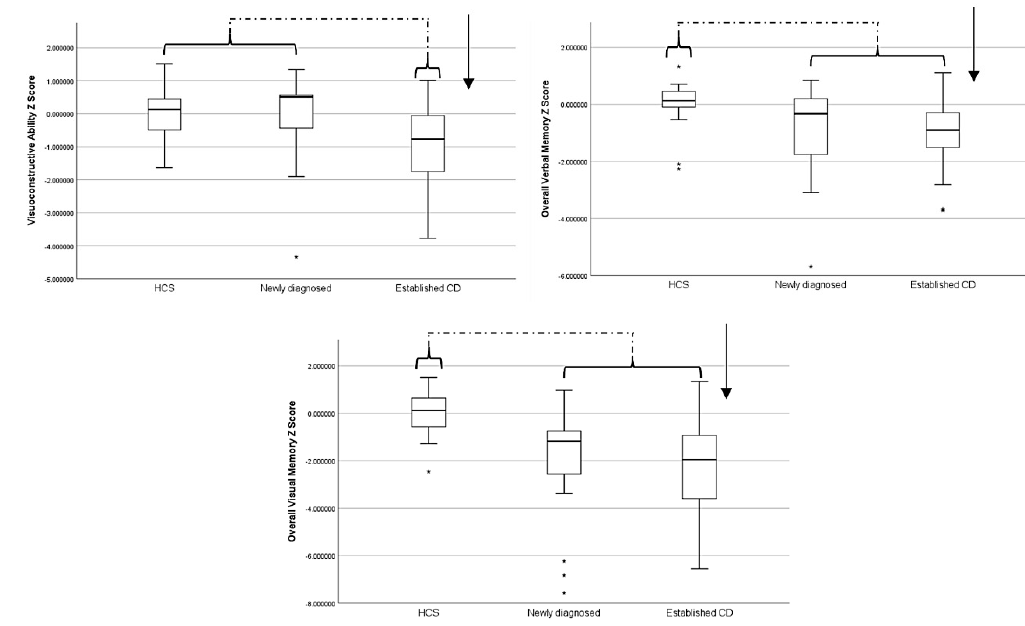
Figure 2. Boxplots visualising group performance on cognitive domains found to be significantly different in statistical analyses. Asterisks represent data points identified as outliers by the statistical software. Brackets and arrows are superimposed to demonstrate the significant difference between groups, with reference to control group performance, within each model. HCS, healthy control subjects.